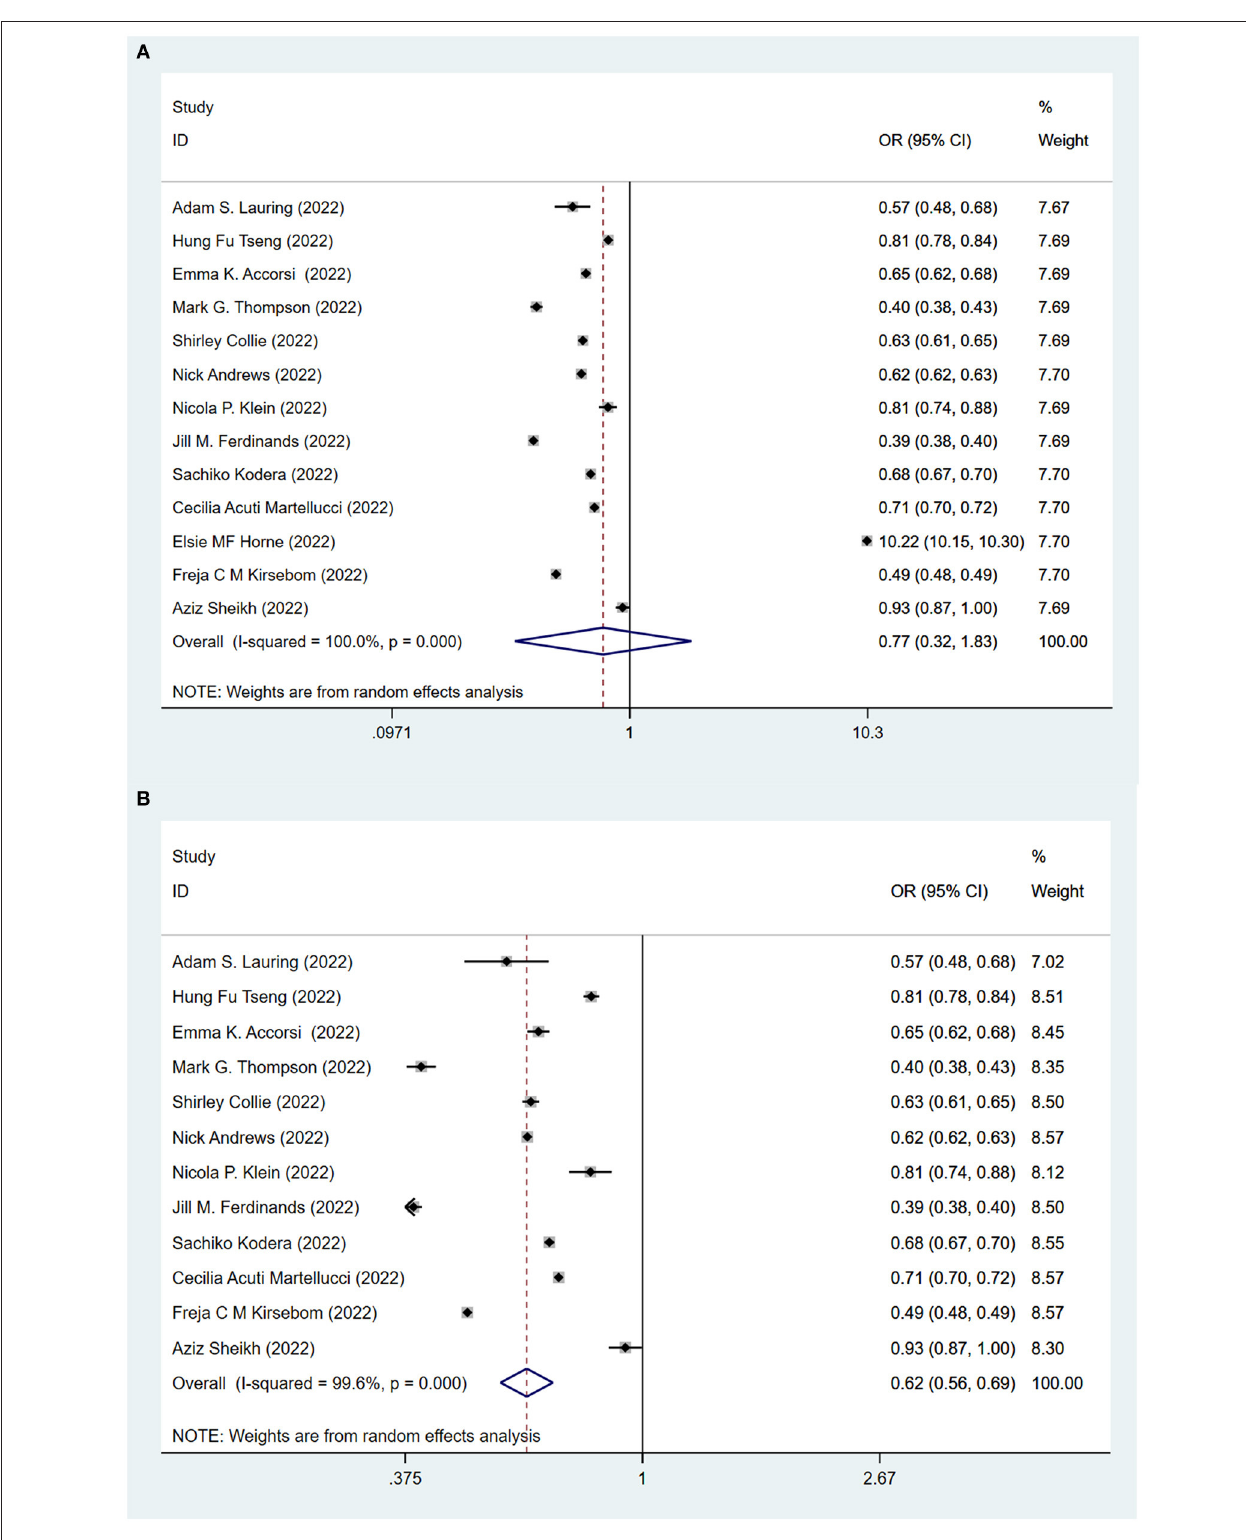
FIGURE 2 | Effectiveness of the fully COVID-19 vaccines (at least two doses) against the Omicron variant compared to the unvaccination. (A) 13 studies included. (B) 12 studies included and excluded one study about effectiveness of vaccines over 6 months since second dose.